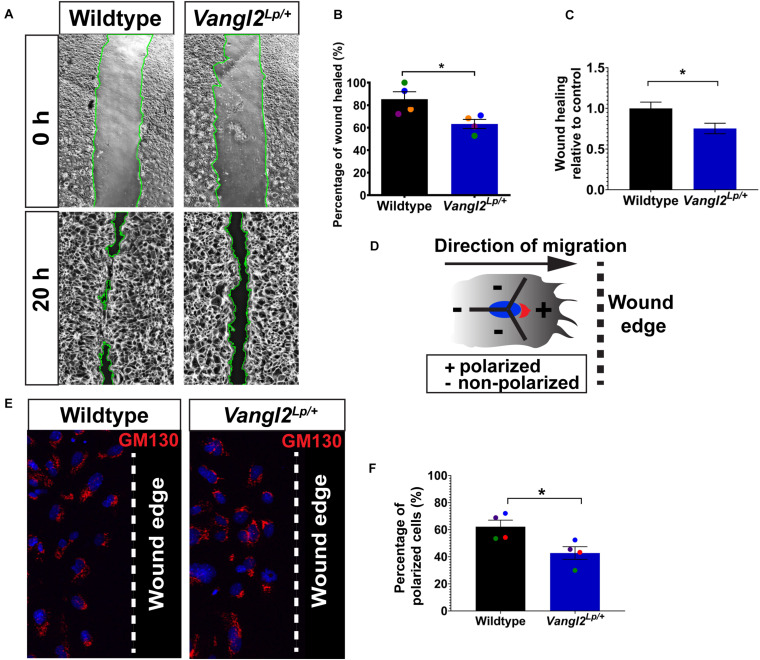
Cell polarity and wound-healing are impaired in Vangl2Lp/+ TECs. (A) Representative images showing wildtype (left panels) and Vangl2Lp/+ TECs (right panels) at 0 and 20 h post-scratch. Wound edges are indicated by green lines. (B) Percentage of wound healed measured at 20 h post-scratch in wildtype and Vangl2Lp/+ TECs. n = 4 independent experiments; TECs from three mice were pooled for each group per experiment; three technical replicates for each group per experiment; each dot represents mean percentage of wound healed per experiment. Mann–Whitney U-test, *p = 0.029. (C) Wound-healing rate in Vangl2Lp/+ relative to wildtype control. n = 4 independent experiments. Mann–Whitney U-test, *p = 0.029. (D) Schematic to illustrate polarized or non-polarized cells at leading edge as determined by the 120° arc drawn from the center of a nucleus (blue) facing the direction of migration (arrow). Golgi (red) that are located within the 120° arc (+) were considered as polarized, whereas cells with the entire or majority of the Golgi localized outside the 120° arc were classed as non-polarized. Arrow shows the direction of migration and dotted line indicates the wound edge. (E) Immunostaining for Golgi marker GM130 (red) in fixed wildtype and Vangl2Lp/+ TECs at 20 h post-scratch. Nuclei were labeled with DAPI (blue). Dotted line indicates the wound edge. (F) Percentage of polarized cells at 20 h post-scratch in wildtype and Vangl2Lp/+ TECs. n = 4 independent experiments; TECs from three mice were pooled for each group per experiment; three technical replicates for each group per experiment; each dot represents mean percentage of wound healed per experiment. Mann–Whitney U-test, *p < 0.05. All data are presented as mean ± SEM.